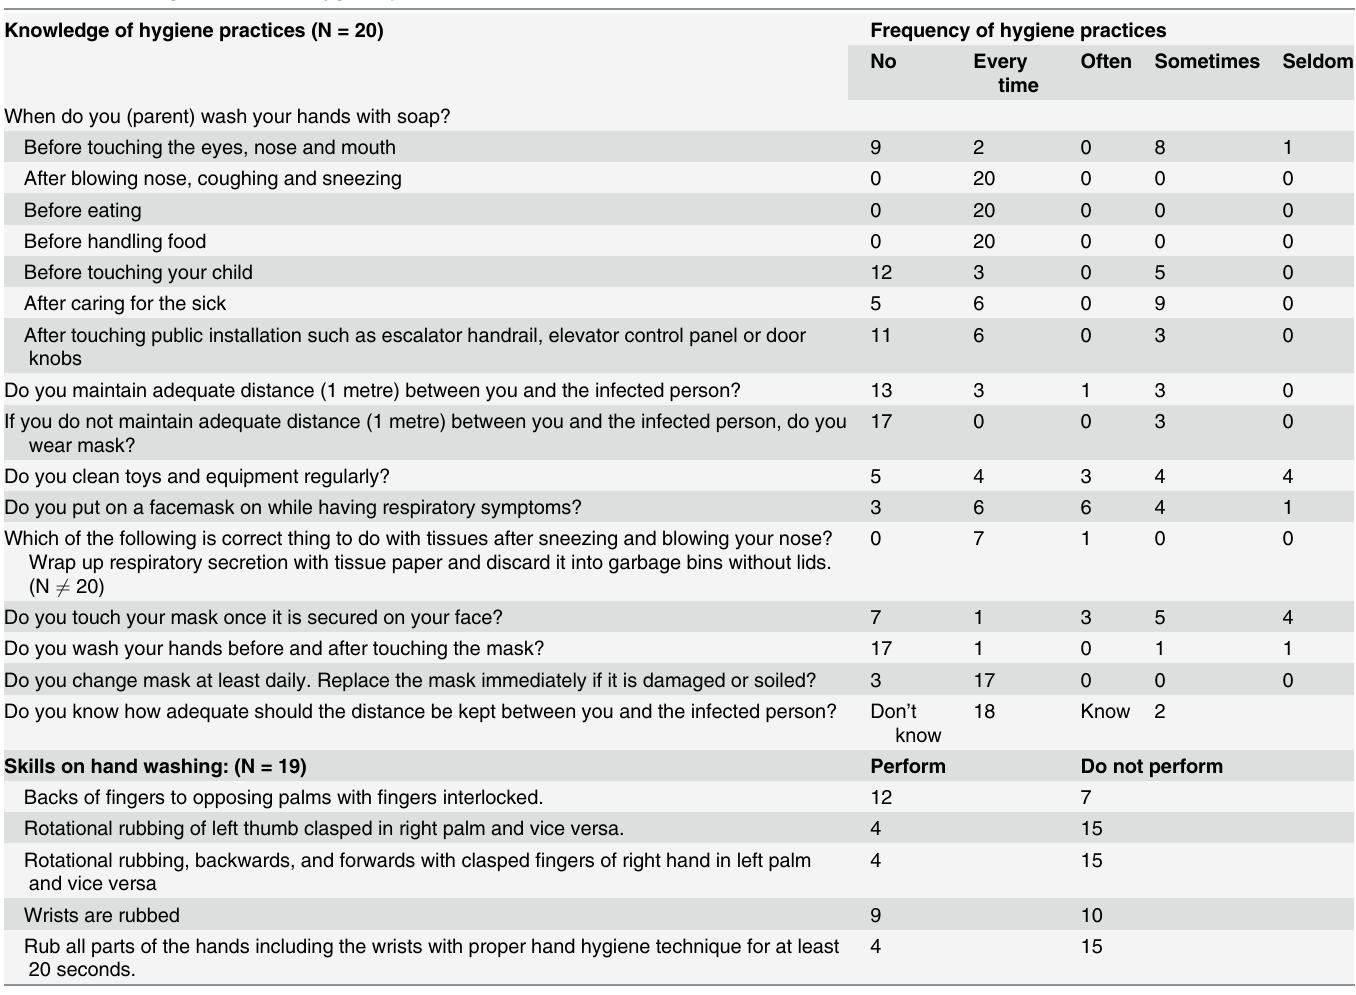
Table 2. Knowledge and skills of hygiene